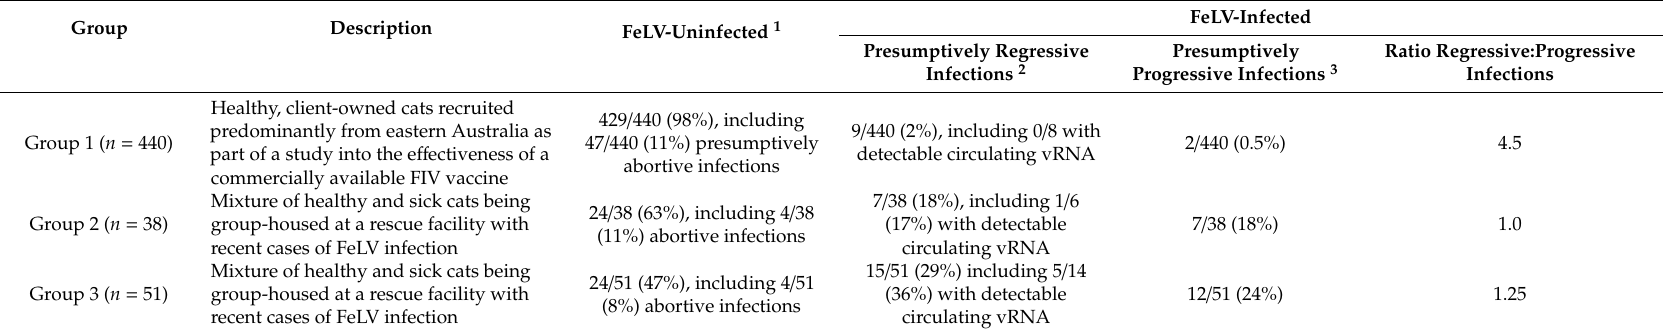
Table 2. Summary of results from the current study.